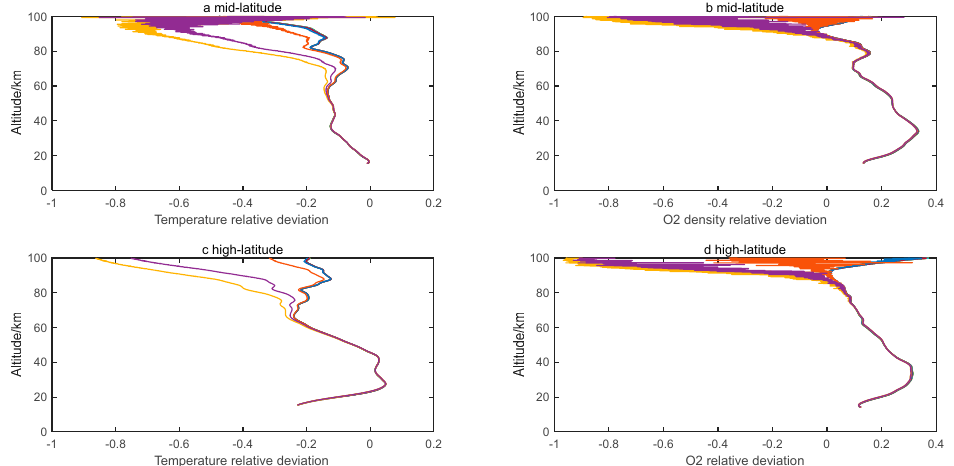
Figure 10. ( a ) Relative deviation of middle latitude temperature; ( b ) Relative deviation of oxygen number density at middle latitude; ( c ) Relative deviation of high-latitude temperature; and ( d ) Relative error of oxygen number density at high latitude. The wavelength represented by each color in the figure is consistent with the previous illustration, so it will not be repeated here.